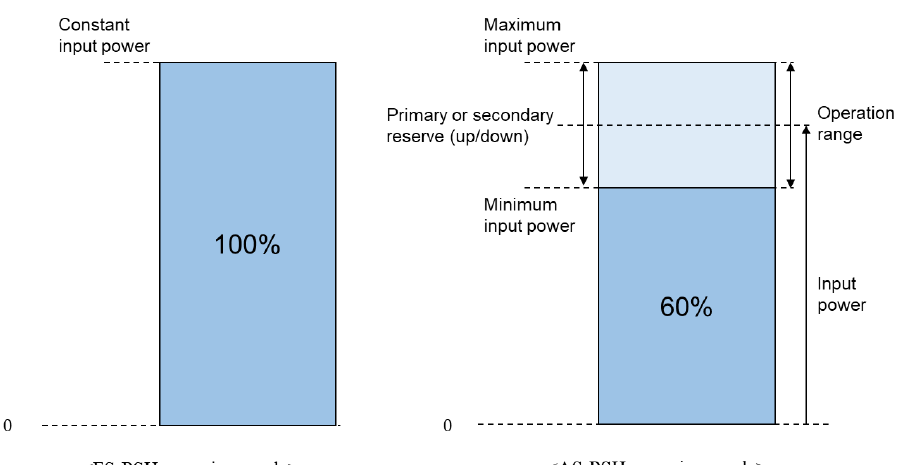
Figure 6. Operation and reserve ranges of PSH (generating mode).